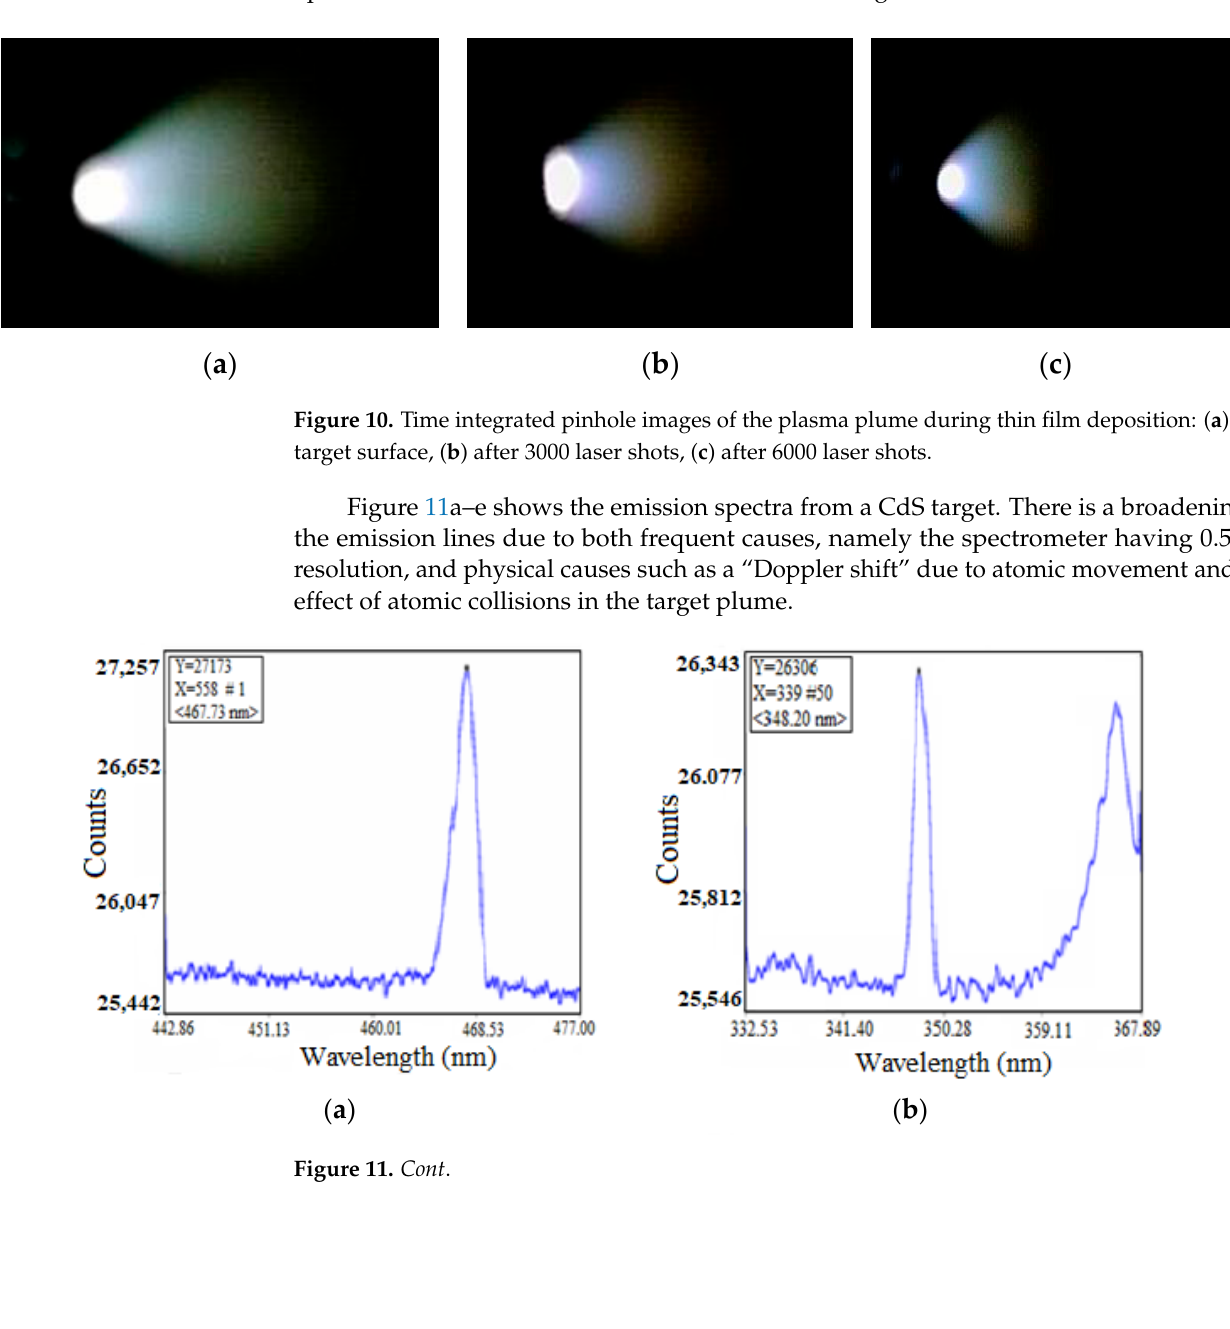
( d ) ( e ) Figure 11. (a-e) Plasma with different spectral line during the deposition. ( a ) 348.2 nm; ( b ) 467.73 nm; ( c ) 508.34 nm; ( d ) 643.70 nm; and ( e ) 477.16 nm. The image profile and three-dimensional profile of the spectral line 477.16 nm are shown in Figure 12a, b. Commented [M4]: The label is not clear, please confirm if you want to change figure. Commented [ha5R4]: The lable is clarified.